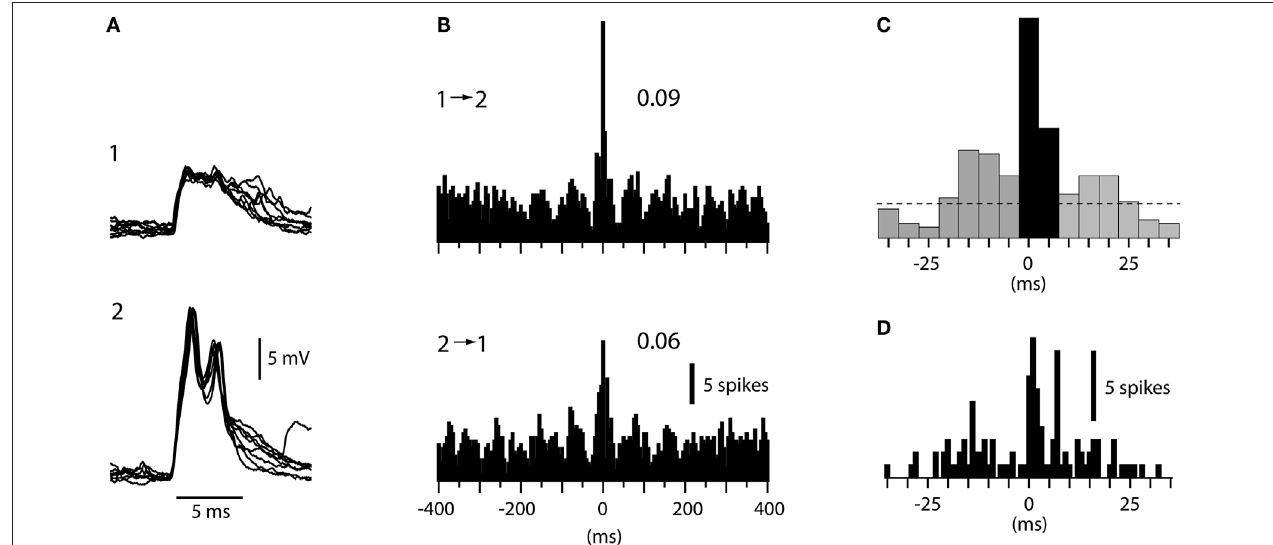
FIGURE 4 | Coupling between dendritic spikes in paired loose patch dendritic recordings. (A) Superimposed dendritic spikes of the two dendritic units. (B) Cross-correlograms of the spontaneous activity of the two dendrites. In the upper histogram, the spike times of dendrite 2 relative to the occurrence of the dendritic spike 1 was plotted. The reverse relationship was plotted in the lower histogram. Numbers indicate degree of coupling. Bar